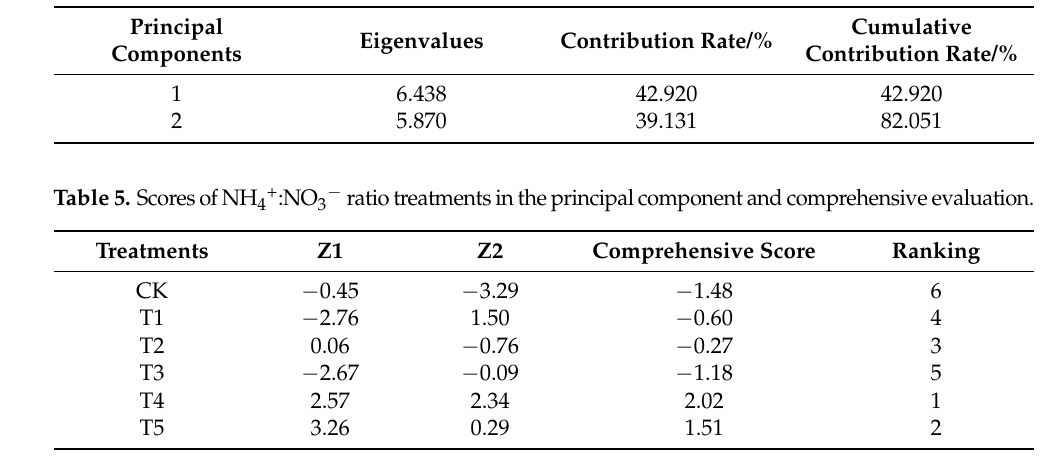
Table 4. The rate of eigenvalue, contribution, and cumulative contribution in principal components.